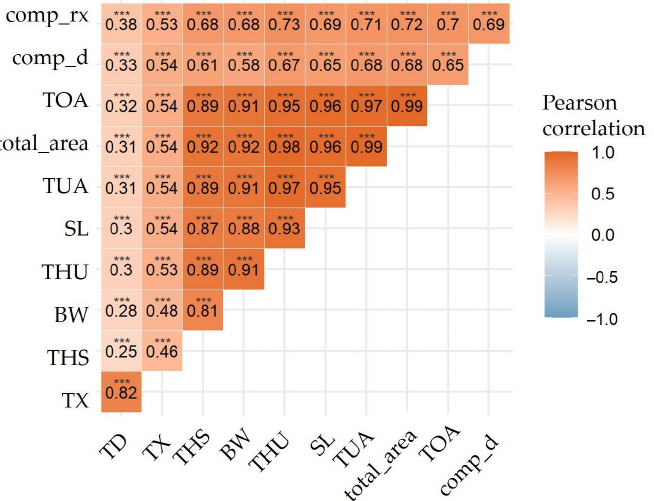
Figure 5. Pearson correlations of IB numbers and lengths from dissection and X-ray imaging methods against morphometrical parameters in tambaqui. TD = total number of IBs by dissection, TX = total number of IBs by X-ray, comp_d = bones length by dissection (mm), comp_rx = bones length by X-ray (mm), SL = standard length (mm), BW = body weight (g), total_area = total area of lateral loin (mm 2 ), TOA = trunk over axis (mm 2 ), TUA = trunk under axis (mm 2 ) THU = tail hindquarters under shaft, THS = tail hindquarters shaft (mm 2 ). *** p < 0.001. The Shapiro–Wilks test